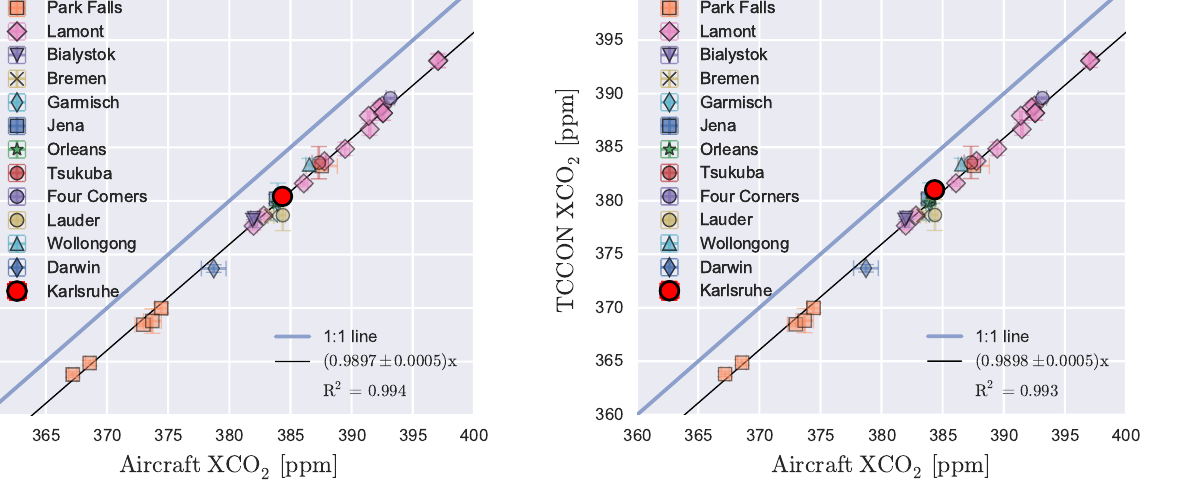
Figure 6. Update of the XCO 2 calibration curve which is discussed in detail in, e.g., Wunch et al. (2010), Messerschmidt et al. (2011), and Geibel et al. (2012) using the continuum fit option for the Karl- sruhe TCCON data.